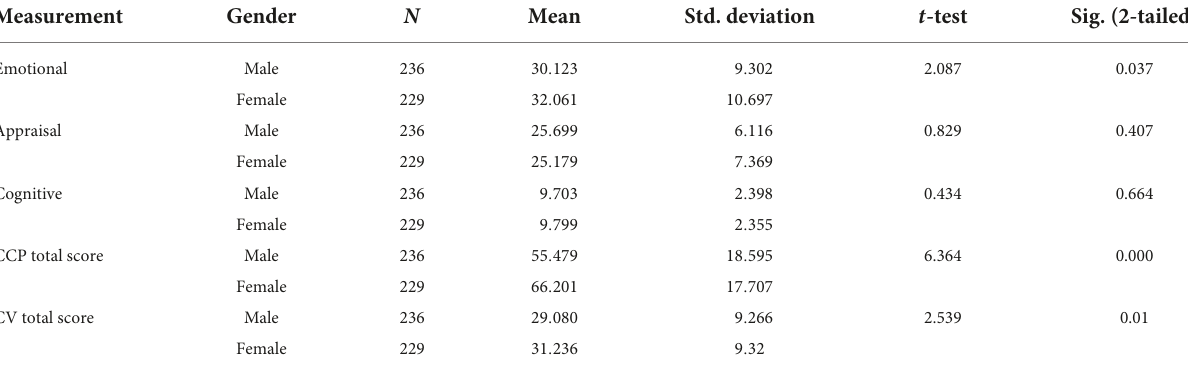
TABLE 4 Differences in climate change perception and climate values due to gender (male/female) variable.